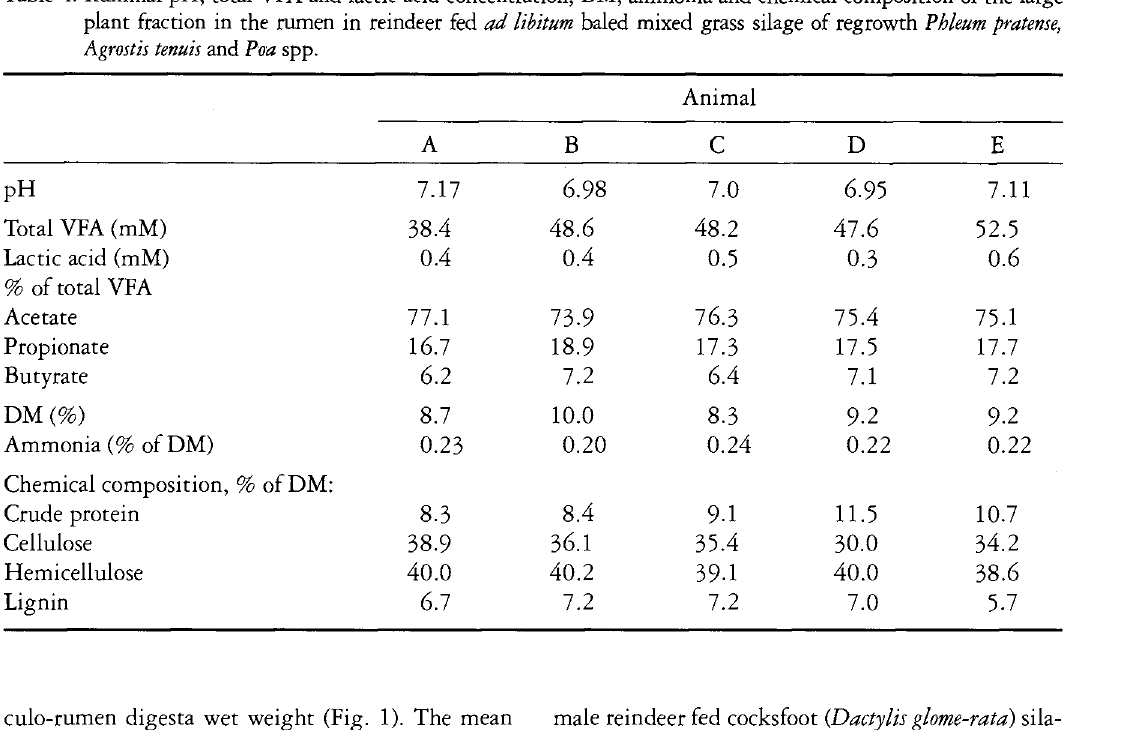
Table 4. Ruminal pH, total VFA and lactic acid concentration, DM, ammonia and chemical composition of the large plant fraction in the rumen in reindeer fed ad libitum baled mixed grass silage of regrowth Phleum pratense, Agrostis tenuis and Poa